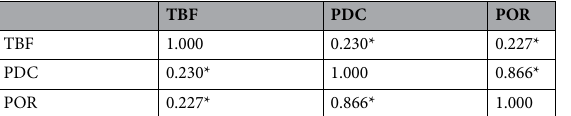
Table 3. Spearman’s rank correlation coefficients between selected tumor budding parameters. Marked correlation coefficients are significant with p <